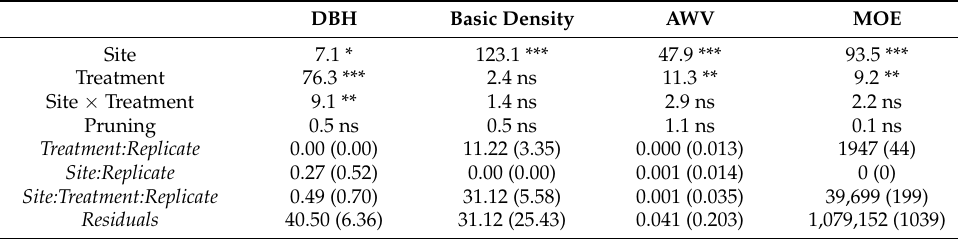
Table 4. Statistics for commercial thinning (EC300) and non-commercial (EW300) vs. control treat- ment across two sites of the Eucalyptus nitens thinning trials. Results are F-tests for fixed effects and variance with standard deviation in parentheses for the random effects. Random effects are denoted in italics. Pruning was considered as a co-variate and was not included in the interaction term.